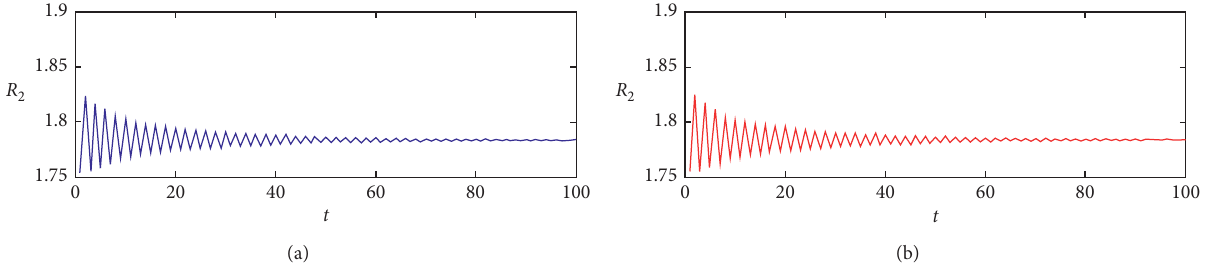
Figure 11: Orbits of R